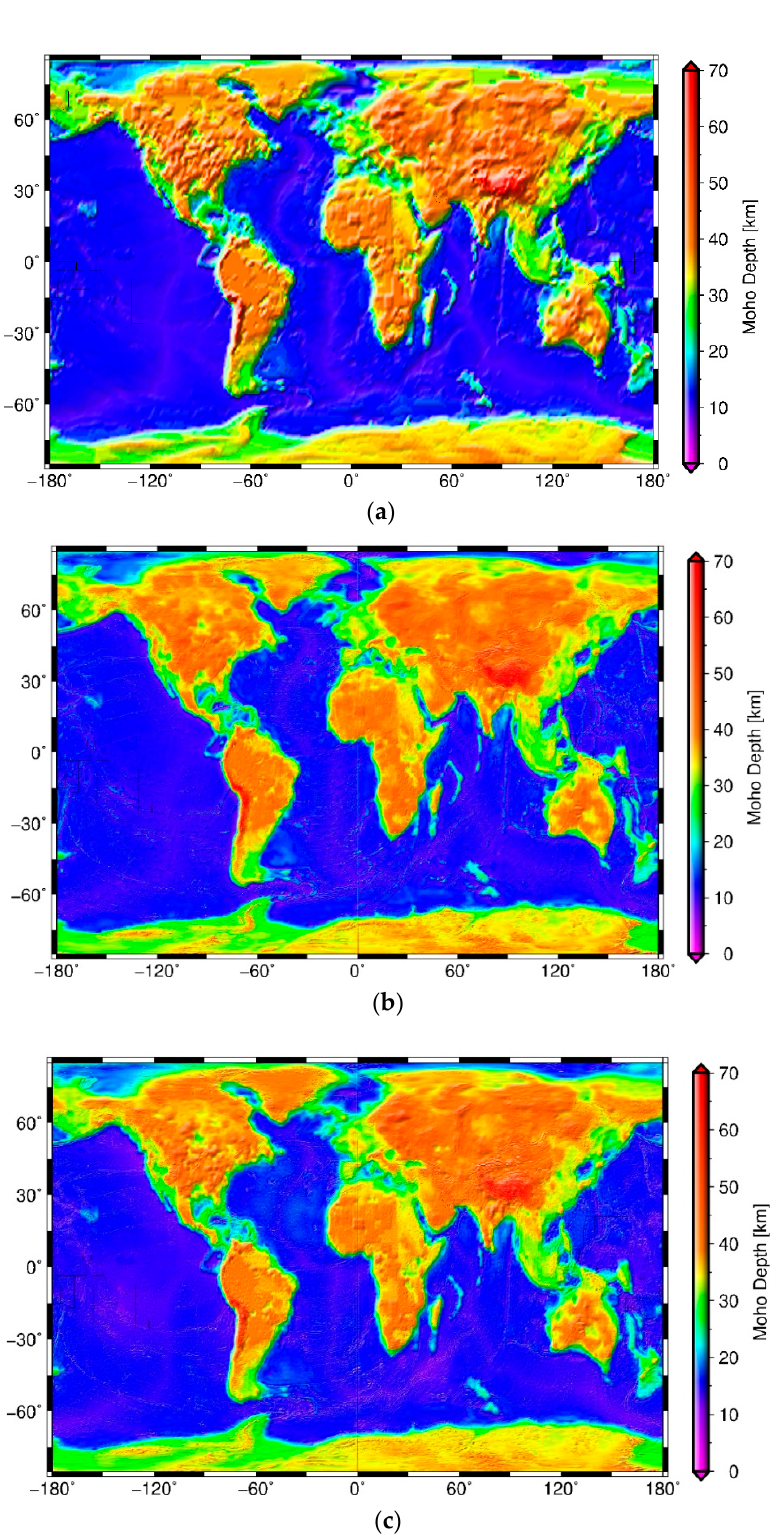
Figure 3. Global Moho depth models: ( a ) the CRUST1.0 model (with the resolution of 1° × 1°), ( b ) the HRCM model obtained by applying the Butterworth filter (with the resolution of 5’ × 5’), and ( c ) the HRCM model obtained by using the spectral combination method (with the resolution of 5’ × 5’).